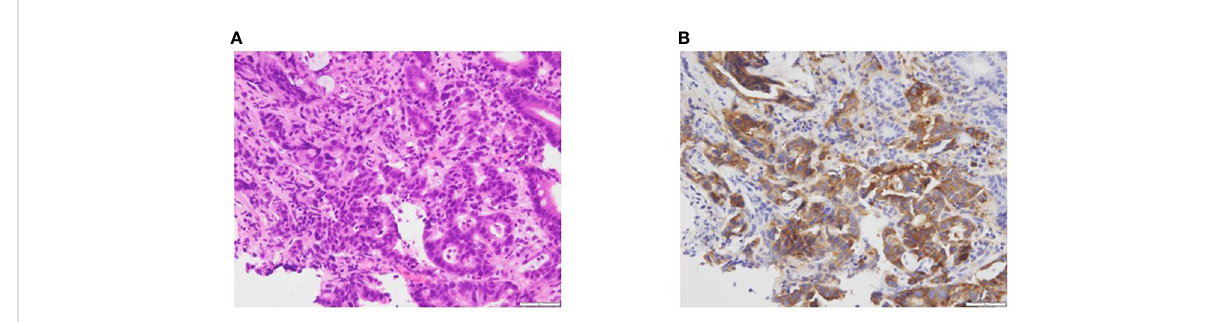
FIGURE 3 (A) Course of tumor markers (carcinoembryonic antigen [CEA] and carbohydrate antigen 19-9 [CA 19-9]) while receiving treatment with FOLFOX and alectinib. (B) Abdominal computed tomography showing multiple liver metastases pre-FOLFOX therapy, increased tumor volume 4 weeks after the FOLFOX therapy, and reduction of liver metastases 6 weeks after alectinib. the second follow-up CT imaging showed continuing response for liver metastases.